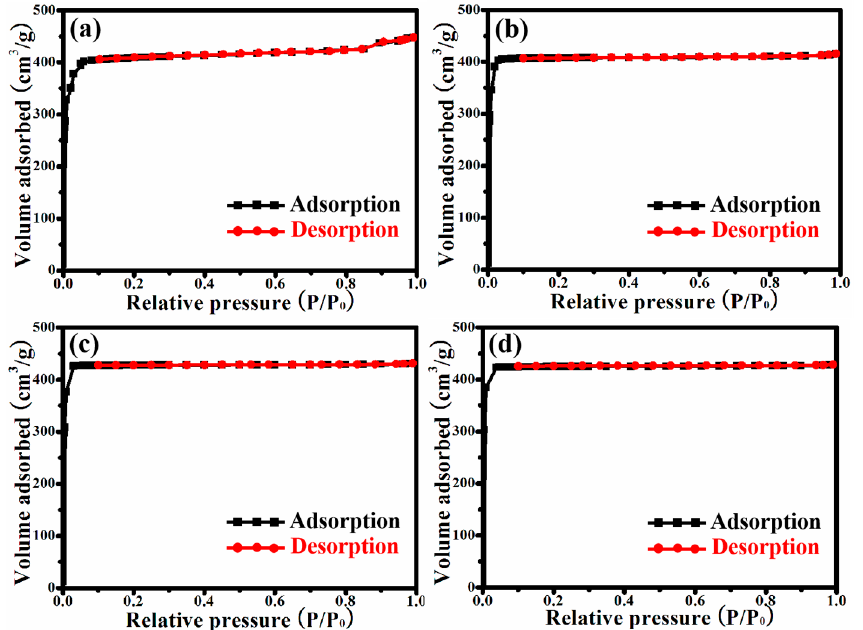
Figure 4. N 2 adsorption–desorption isotherms of ( a ) ZIF-8(1), ( b ) ZIF-8(2), ( c ) ZIF-8(3), ( d ) ZIF-8(4).